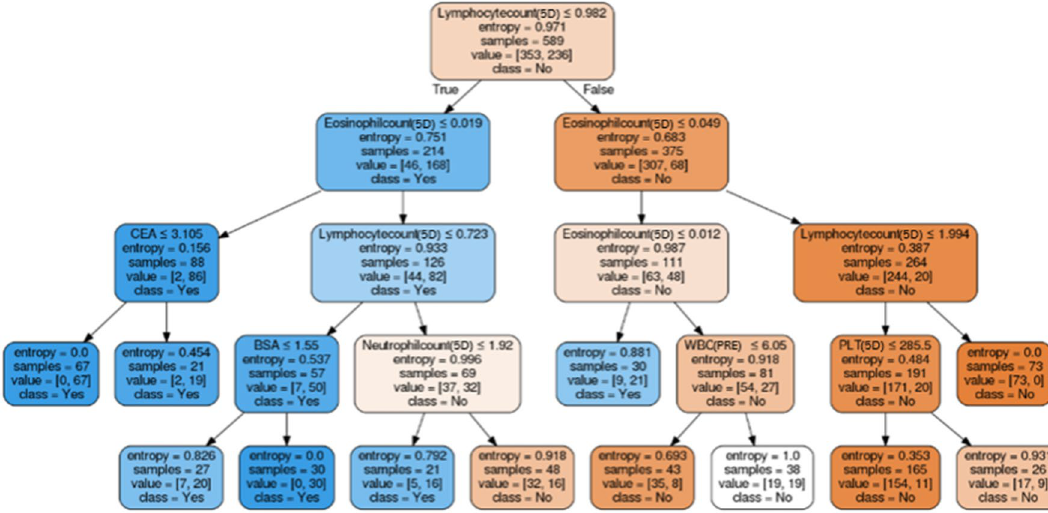
Figure 2. Detailed cut-off values displayed in a decision tree model. The image was drawn in Python 3.6. 5D 5 days after chemotherapy, CEA carcinoembryonic antigen, BSA body surface area, WBC white blood cell, PRE pretreatment, PLT